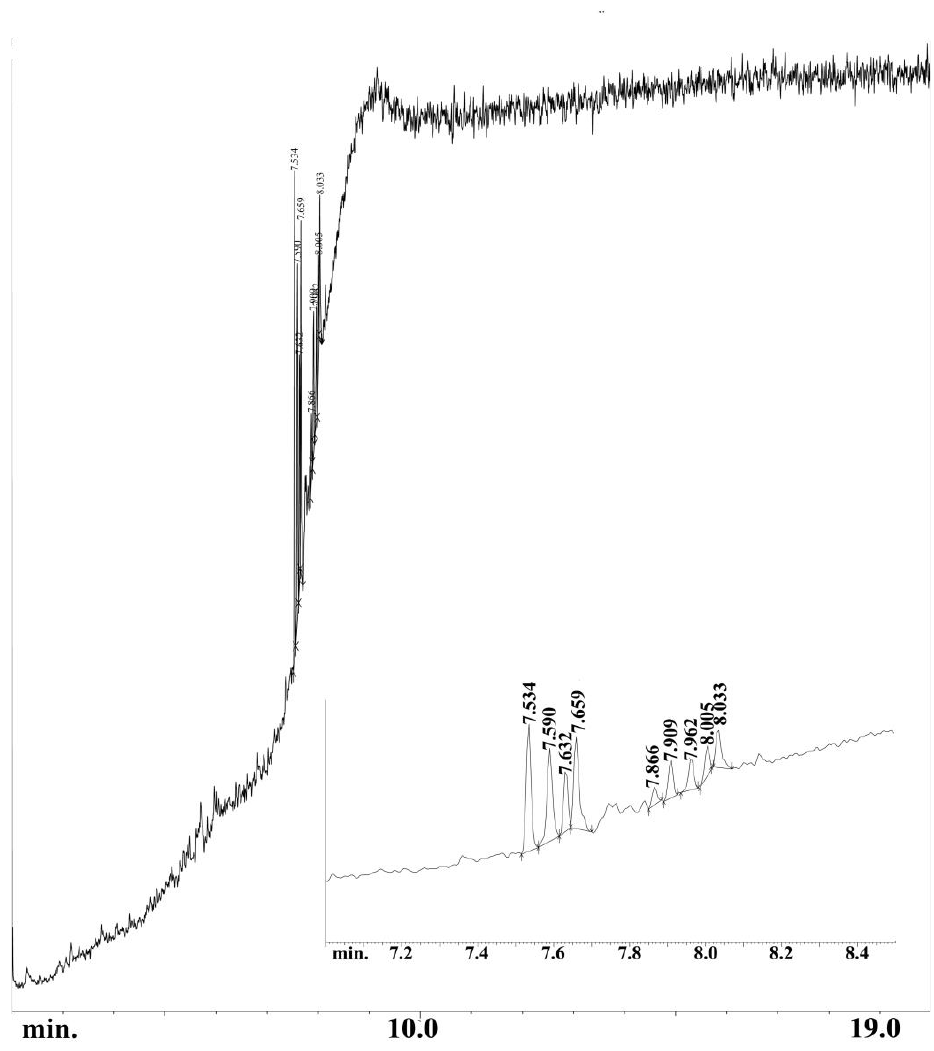
Figure 5. GC-MS chromatogram of the municipal sewage sludge tar.